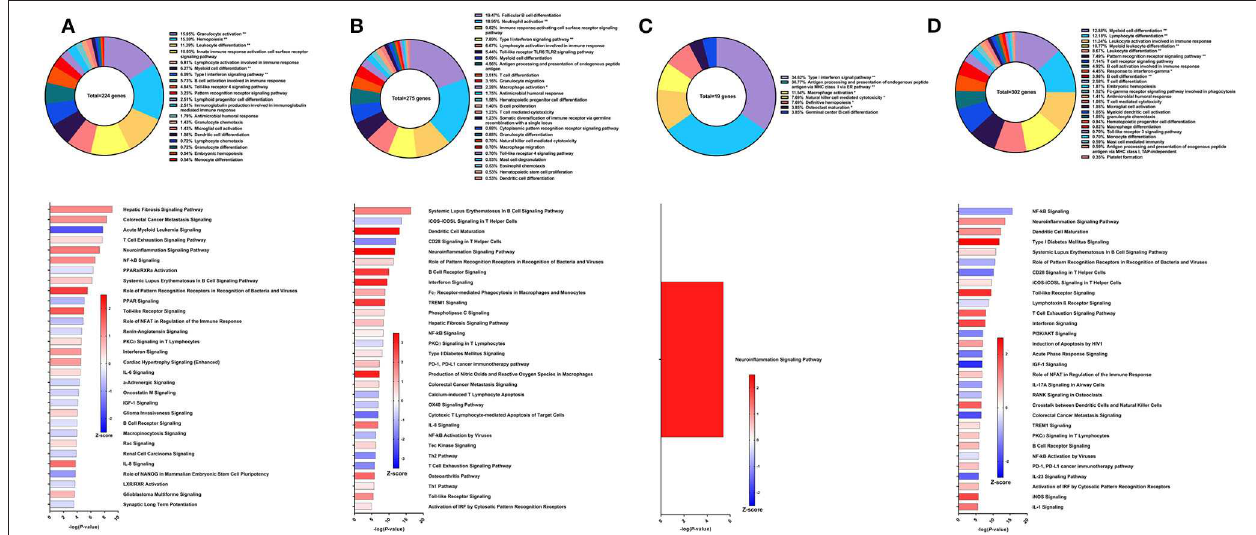
FIGURE 6 | RNA-Seq analysis of rSm-p80 + Resiquimod, a recombinant protein vaccine strategy. (A) PBMCs after vaccination (Top) Gene ontology enrichment analysis represented as a pie graph of percentages of genes per group out of a total number of differentially expressed genes. “**” and “*” indicates P < 0.05 and P < 0.01, respectively. (Bottom) Canonical pathway analysis generated using IPA. Bars are plotted based on the – log10( P -value) and colored based on predicted activation (red) and deactivation/inhibition (blue) according to the Z-score, a composite assessment based on the degree of overlap between directional expression of genes from the observed data and the Qiagen-curated public database. The top 30 pathways are shown based on the lowest P -values. (B) PBMCs after challenge (Top) Gene ontology enrichment analysis. (Bottom) Canonical pathway analysis generated using IPA. (C) Spleen cells (Top) Gene ontology enrichment analysis. (Bottom) Canonical pathway analysis generated using IPA. (D) Mesenteric lymph node cells (Top) Gene ontology enrichment analysis. (Bottom) Canonical pathway analysis generated using